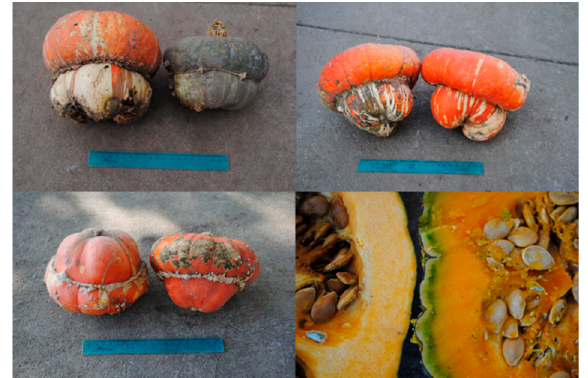
Figure 3. Mature fruits from different accessions of C. maxima Hubbard Cultivar-group. Public domain photos, Germplasm Resources Information Network (GRIN), USA.